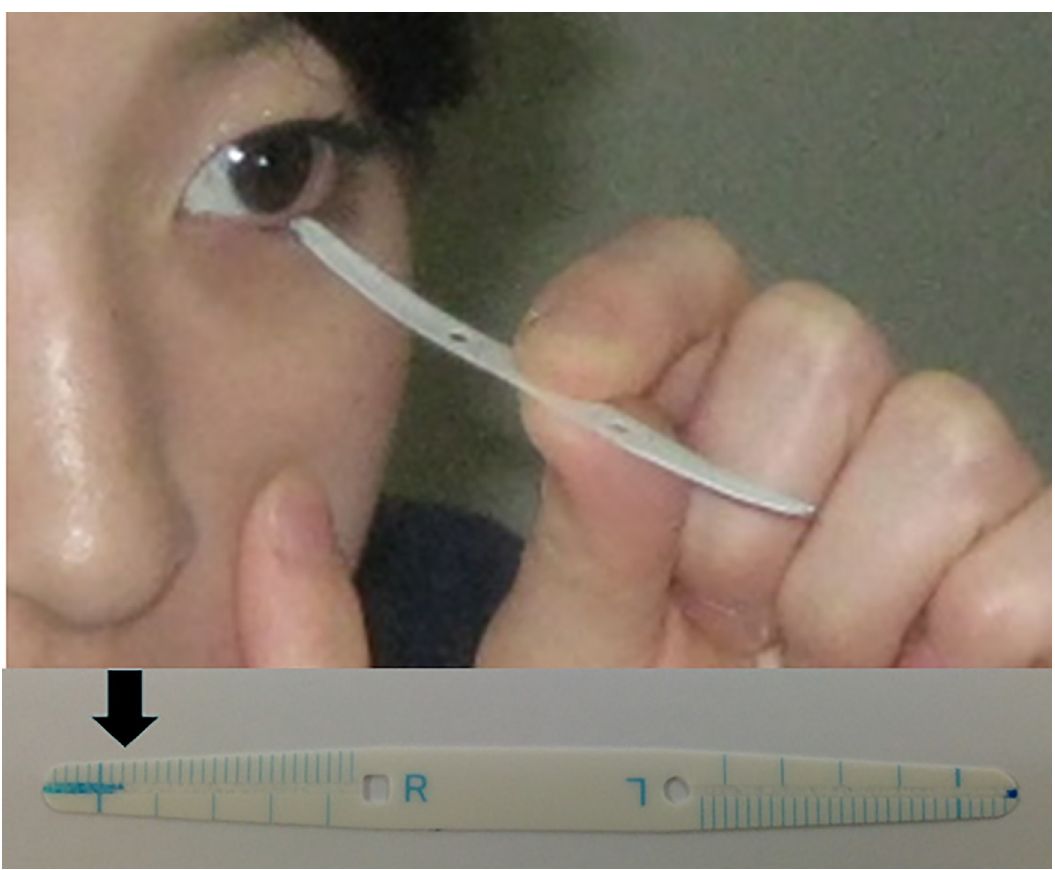
Fig 1. Strip meniscometry self-examination technique. Strip meniscometry (SM) self-examination can be performed using a mirror (top). The length of the blue line (arrow) is regarded as the SM value in the eye